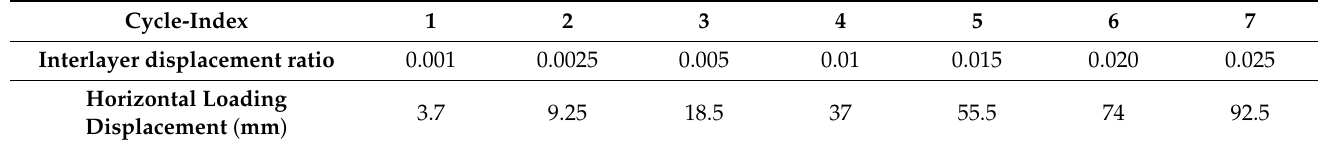
Table 5. SPSW displacement loading system parameters.